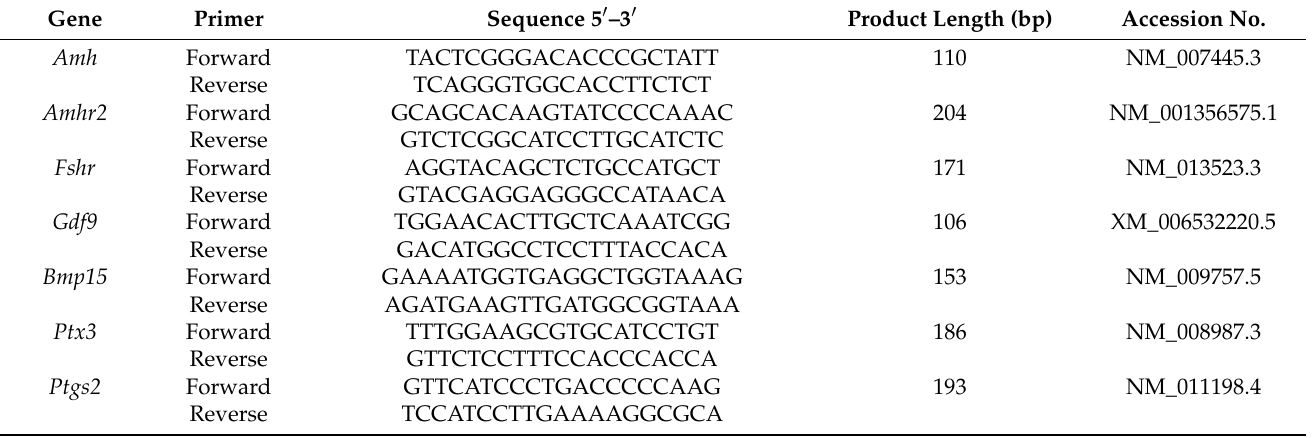
Table 1. Primer information in this